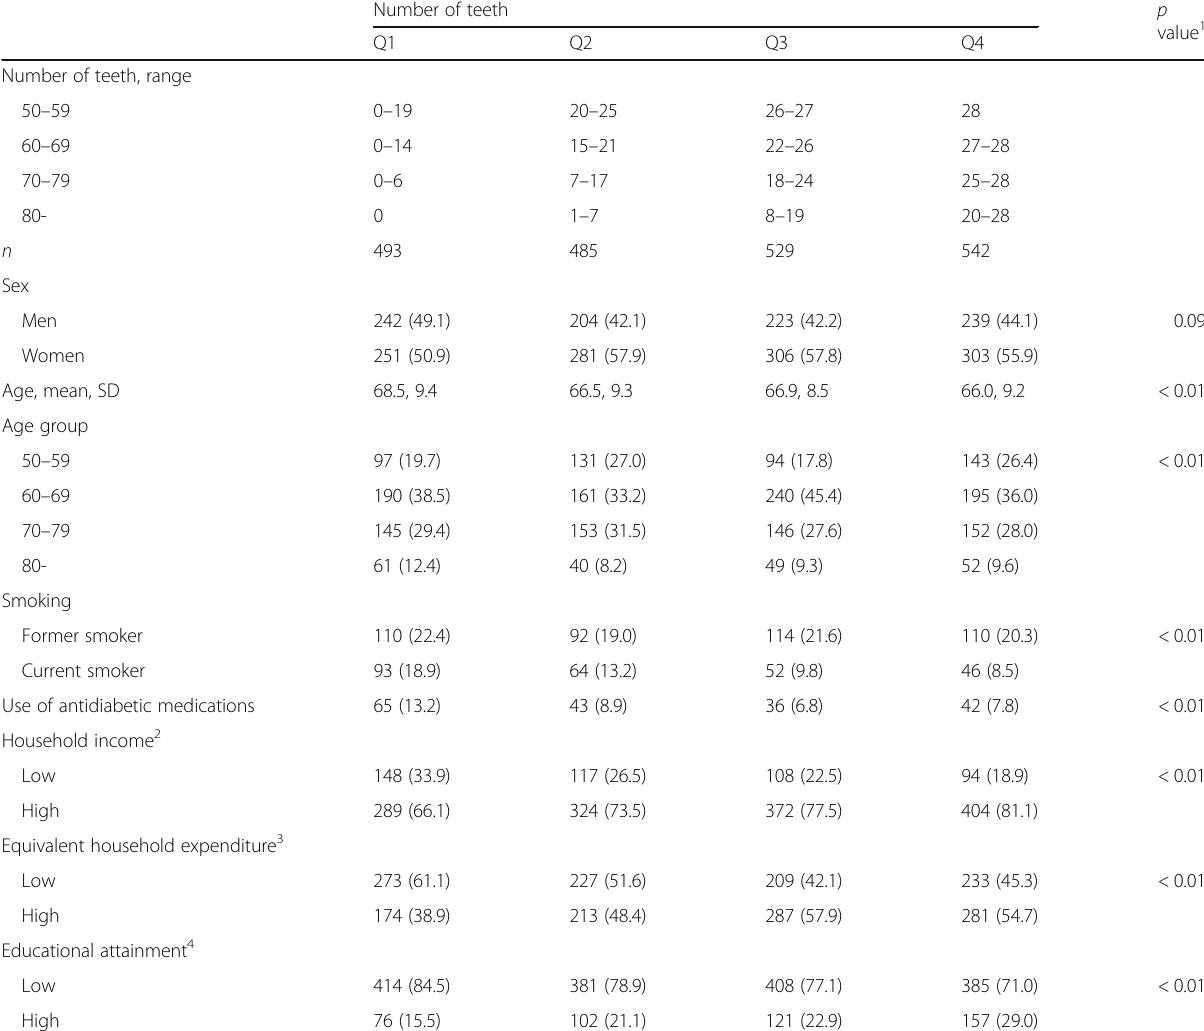
Table 1 Characteristics of the subjects by the number of teeth (brackets contain percent) Number of